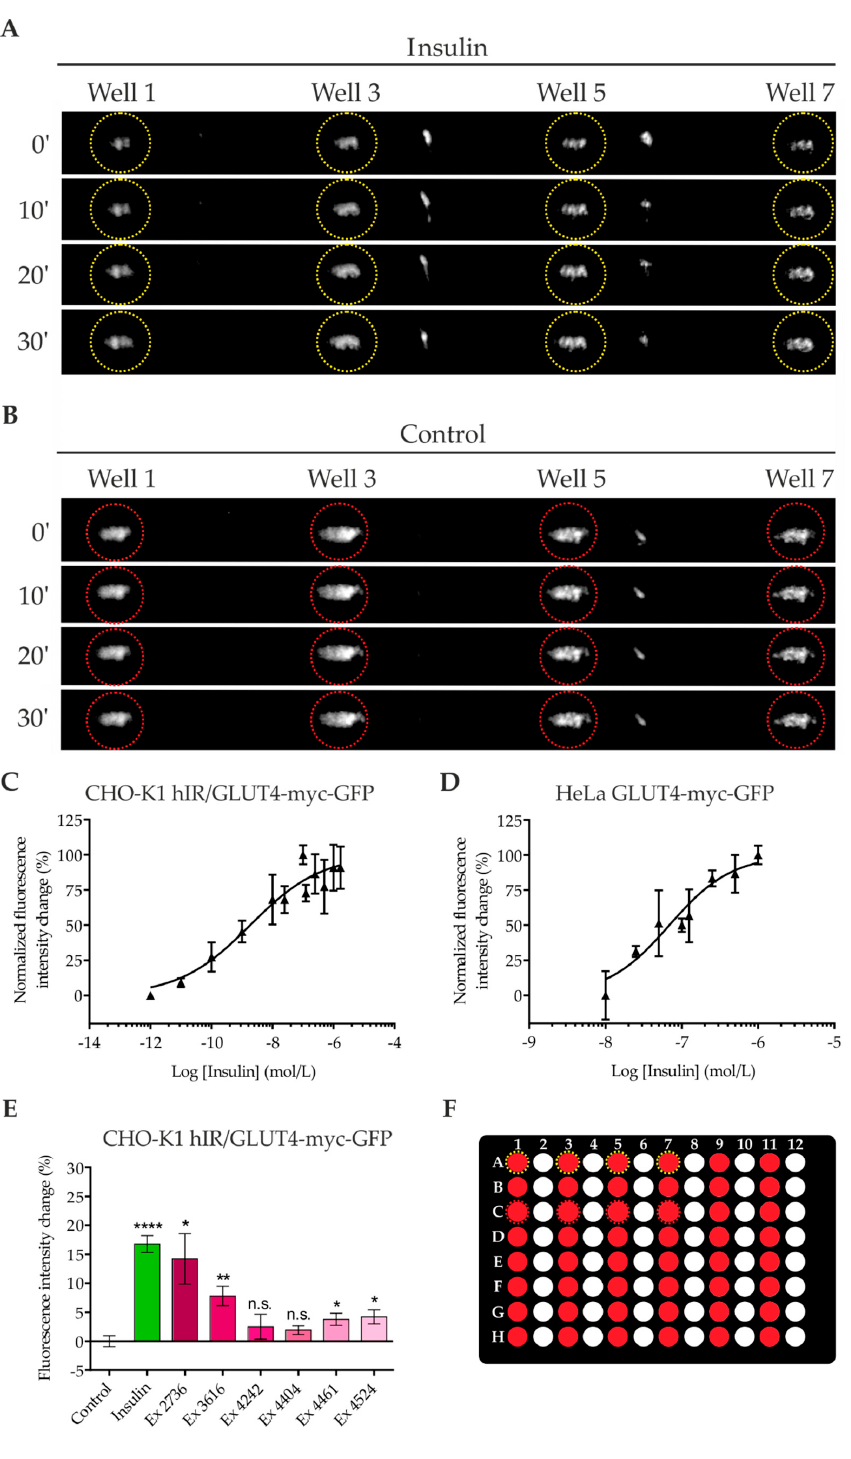
Figure 2. Quantitation of GLUT4 translocation using a prism-type TIR reader. CHO-K1 ( A – C , E ) and HeLa ( D ) cells stably expressing a GLUT4-myc-GFP fusion protein were seeded into adapted 96-well microtiter plates and starved for 3 h in HBSS buffer on the following day. Images in the TIR configuration were taken before and after stimulation with insulin or the indicated plant extracts. Four selected wells with insulin-treated (yellow dashed circles, ( A ) and ( F )) or control cells (red dashed circles, ( B ) and ( F )) were used for illustration. Insulin dose–response curves were generated by quantitation of the fluorescence signal intensity increase induced within 10 (CHO-K1) and 20 (HeLa) min by various insulin concentrations ( C , D ). Values represent the mean ± SEM ( n > 500). * p < 0.05, ** p < 0.01, and **** p < 0.0001 indicate statistically significant di ff erences from the untreated